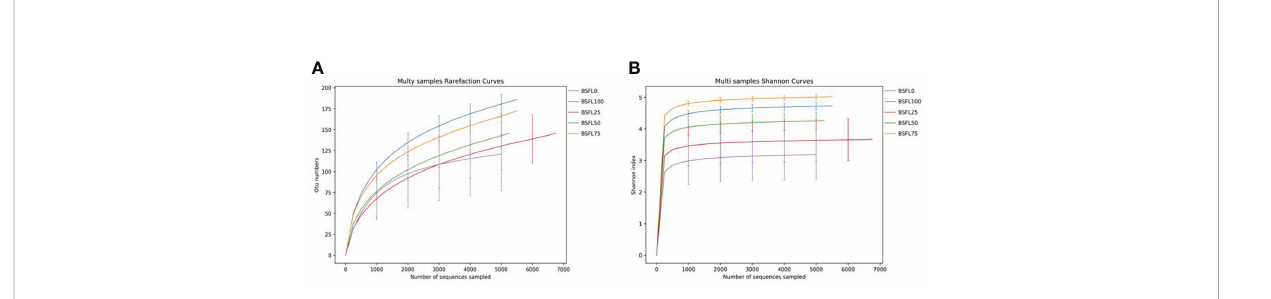
FIGURE 2 Rarefaction curves (A) and Shannon-Wiener curves (B) of the intestinal bacterial community of L. vannamei fed with diets having different levels of BSFL for 45